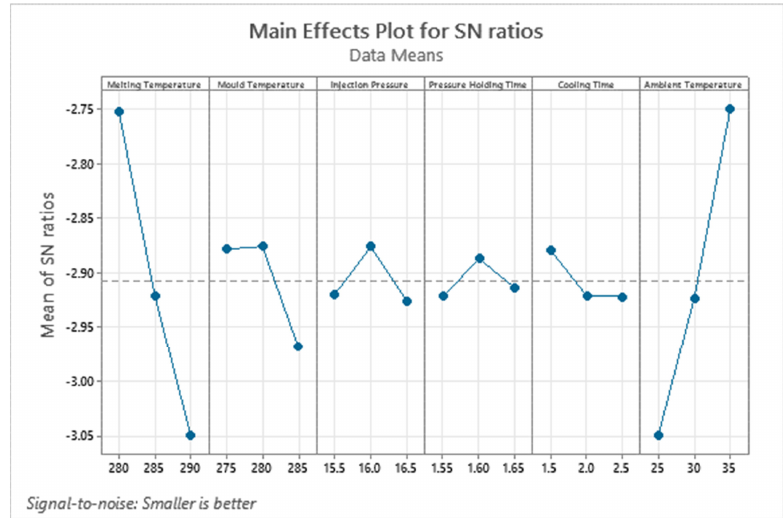
Figure 7. Main effect plot for S/N ratio .